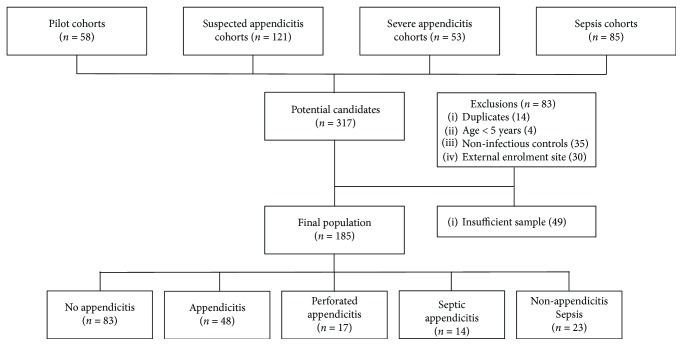
Selection of study candidates and final illness categories.